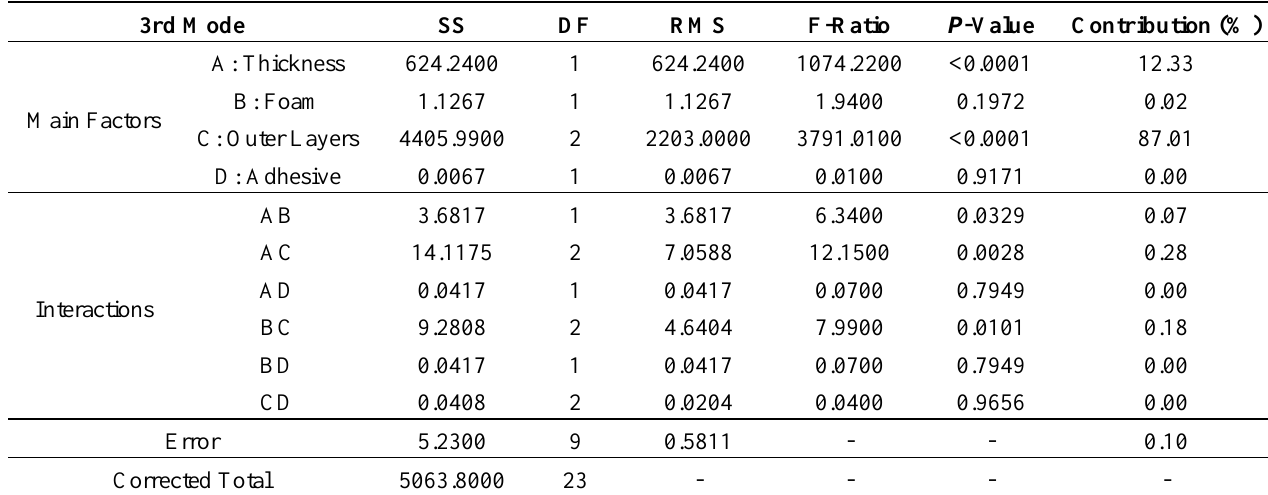
Table 8. 3rd Mode: Analysis of Variance.